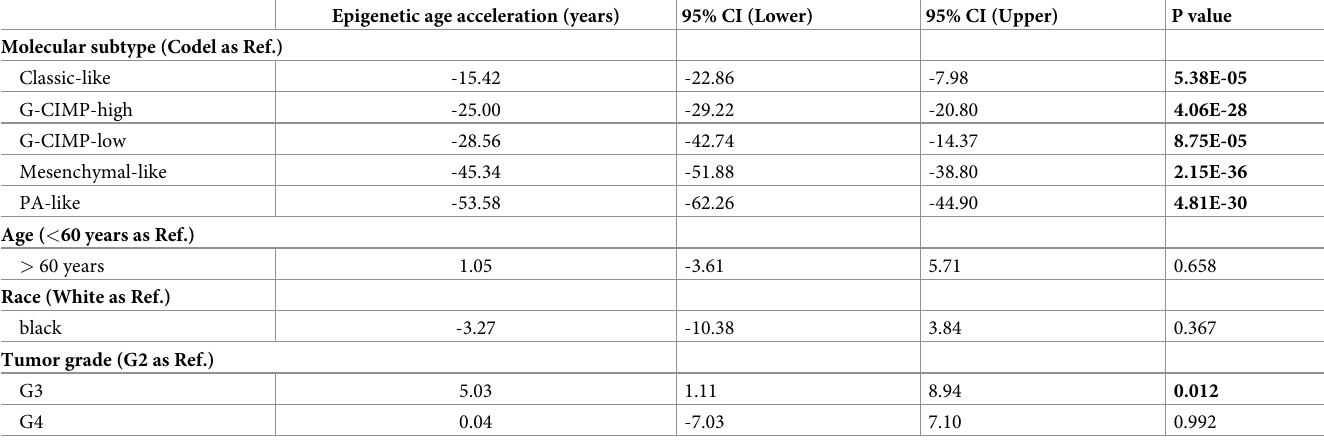
Table 2. The associations of epigenetic age acceleration with clinical variables.